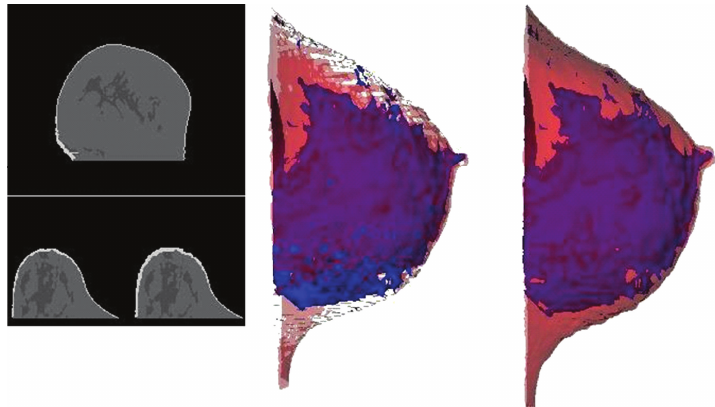
Figure 4: From left to right: one thickness skin artifact (up) and skin growing e ff ect after skin pixel addition (down); skin with holes; reconstructed